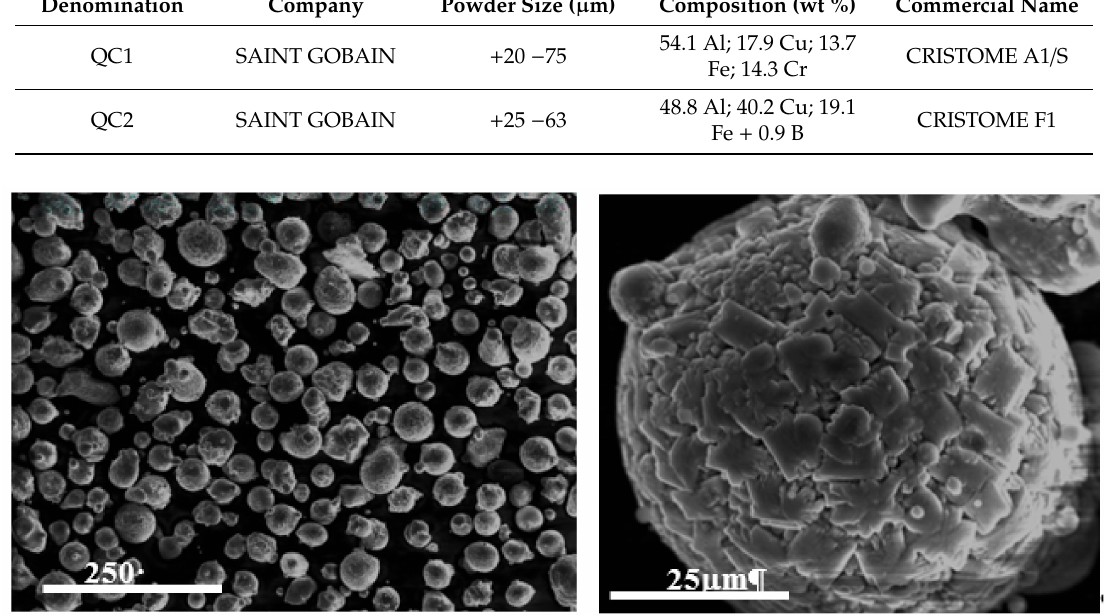
Figure 2. Field Emission Scanning Electron Microscope (FESEM) images of atomized QC powders employed to produce the